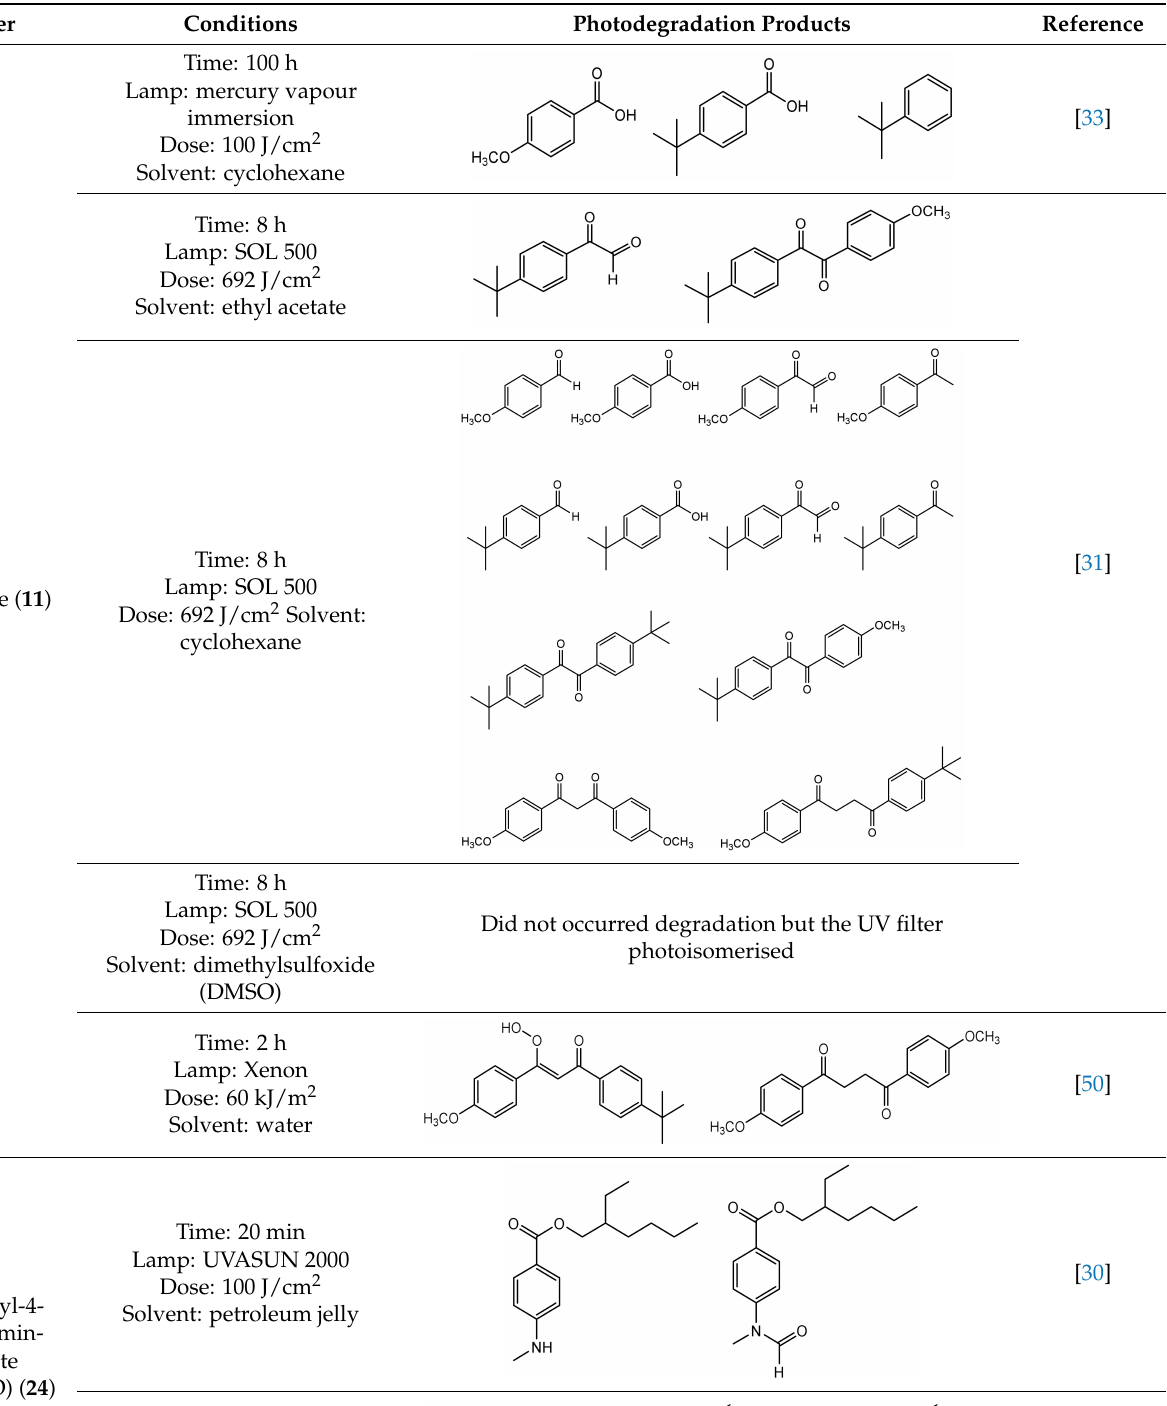
Table 1. Photodegradation products of commercialised UV filters that were study regarding to their photo-induced